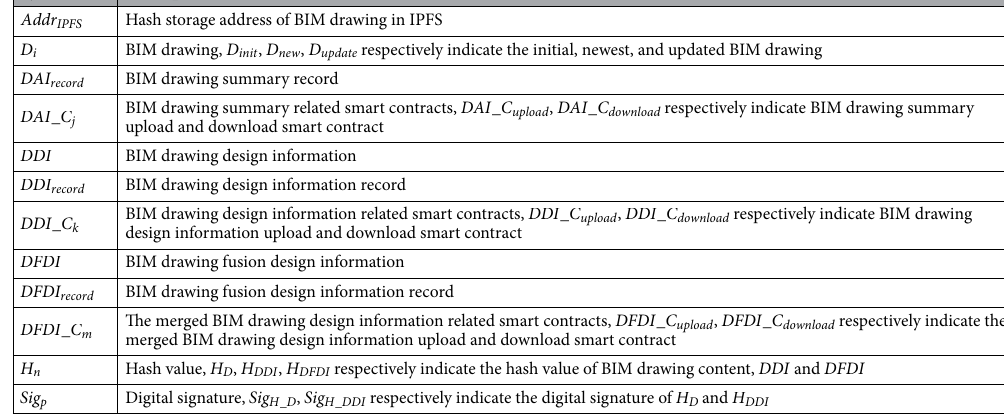
Table 2. Formal description of stored content.